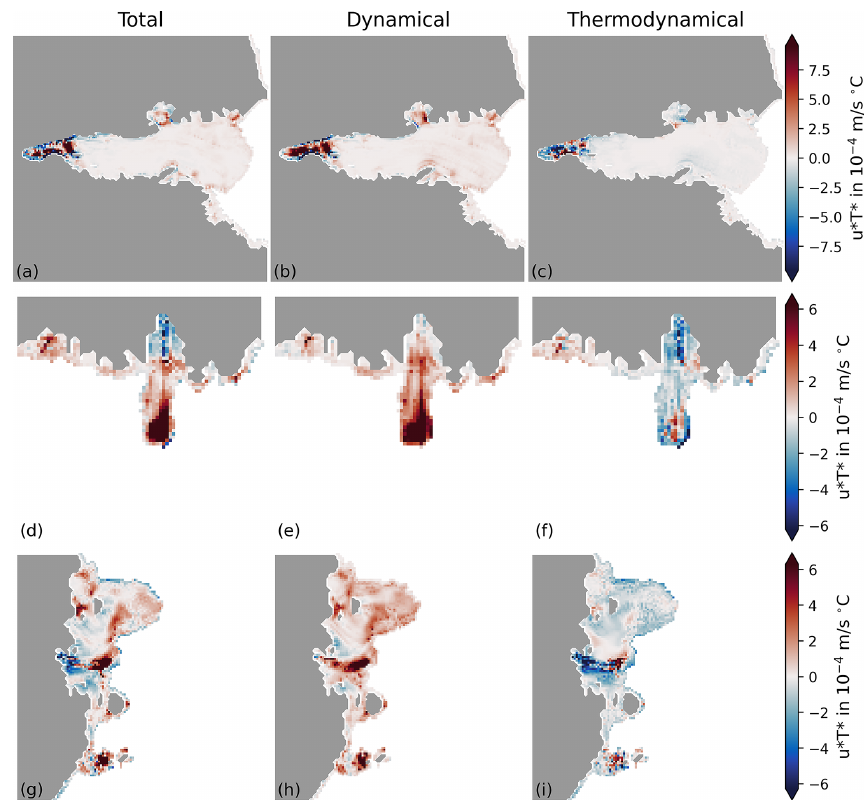
Figure B1. Dynamical–thermodynamical decomposition of tidal melting under Amery (a–c) , Mertz (d–f) and Shackleton (g–i) ice shelves; see Sect.